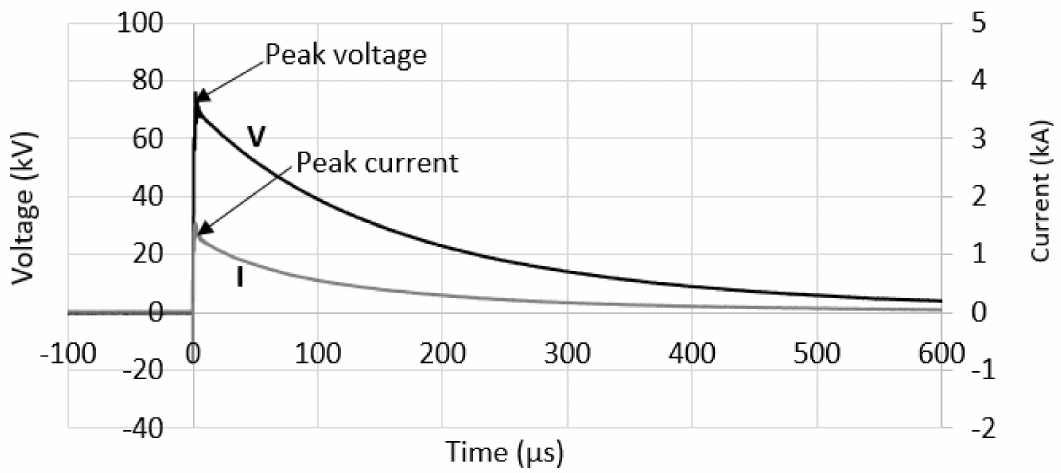
Figure 2. Voltage and current traces of GE 5, at charging voltage of positive impulse polarity at 100